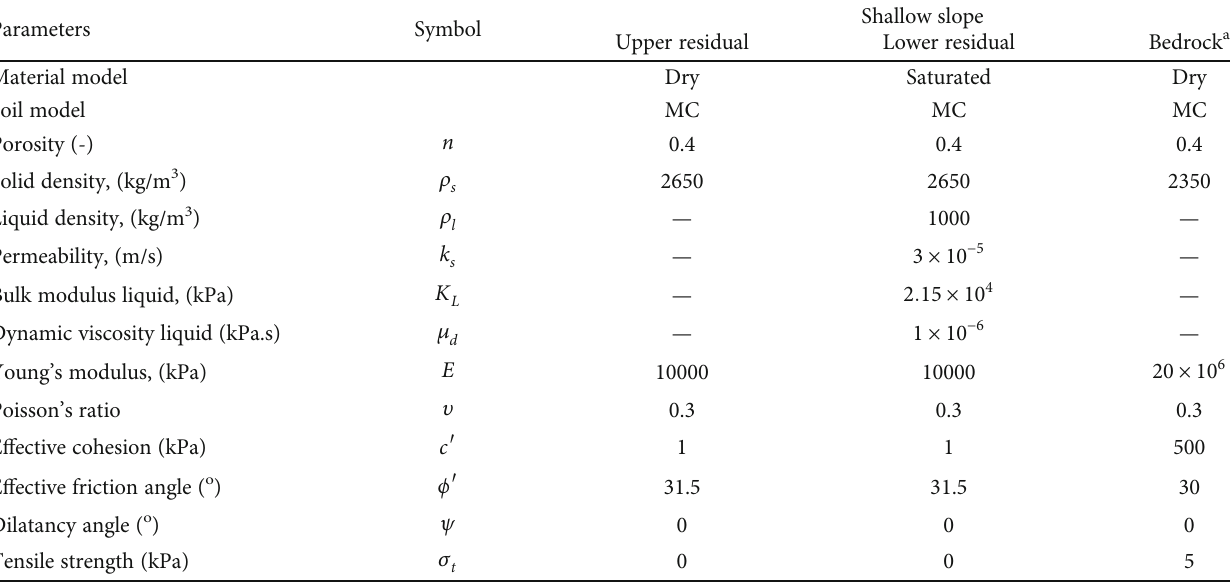
Table 2: Material properties for the analyses of the baseline